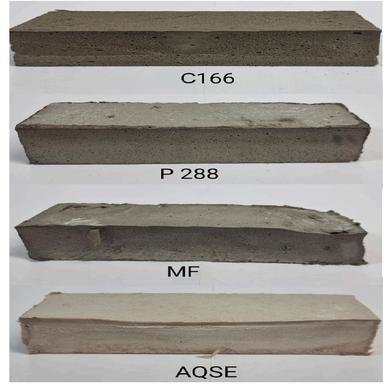
The images of prism of waterproof mortars specimens with a size of 40 mm × 40 mm × 160 mm from de top to bottom are: C166, P288, MF and AQSE.